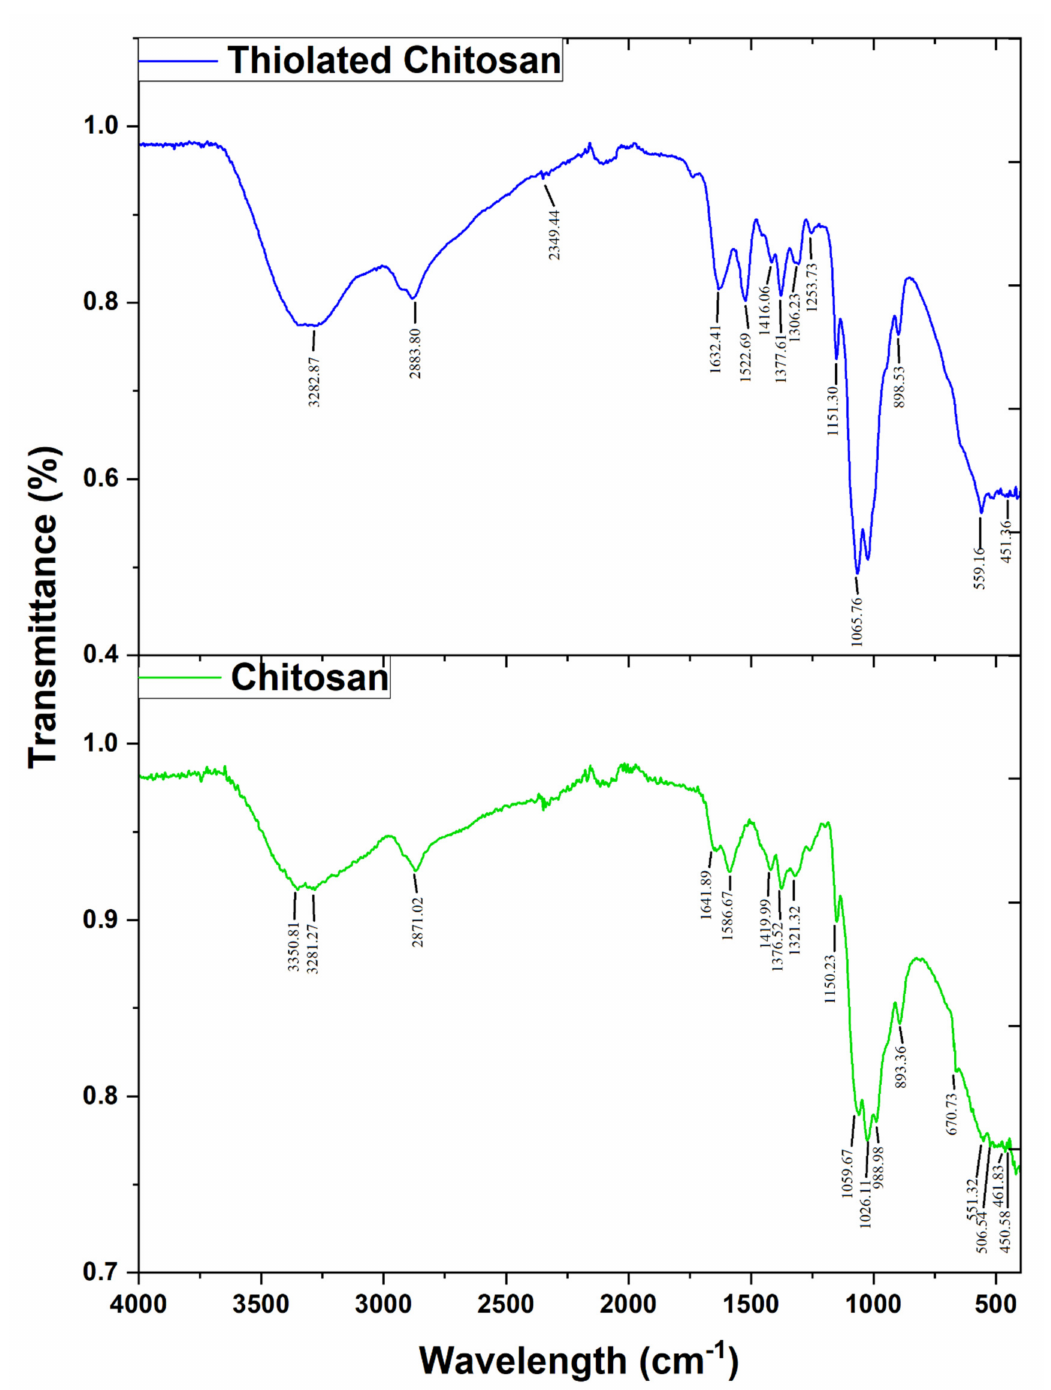
Figure 3. Fourier-transform infrared-attenuated total reflectance (ATR-FTIR) spectra of chitosan and thiolated chitosan synthesized by covalent bond formation between thioglycolic acid and chitosan via EDAC